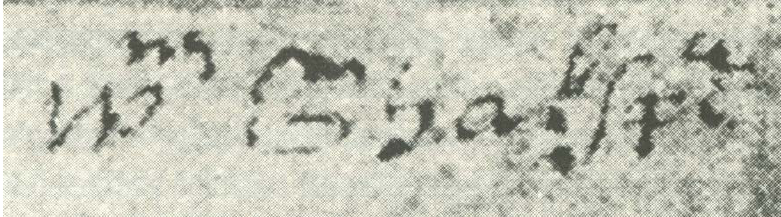
Fig. 3 – Signature n. 3 on the Blackfriars Gatehouse mortgage